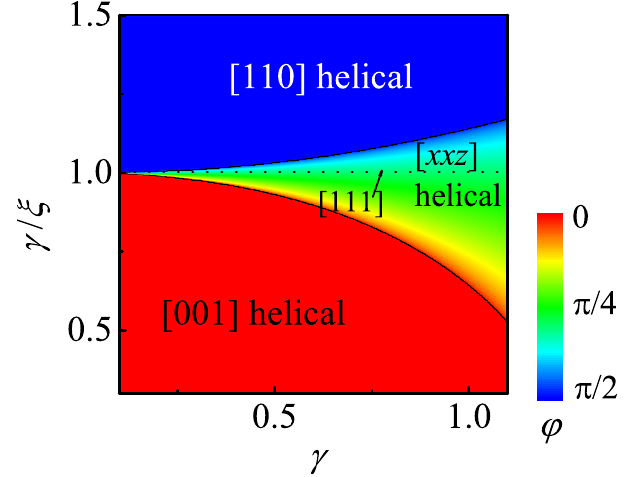
Figure 3. The ground-state phase diagram in the space of ( γ , γ / ξ ).